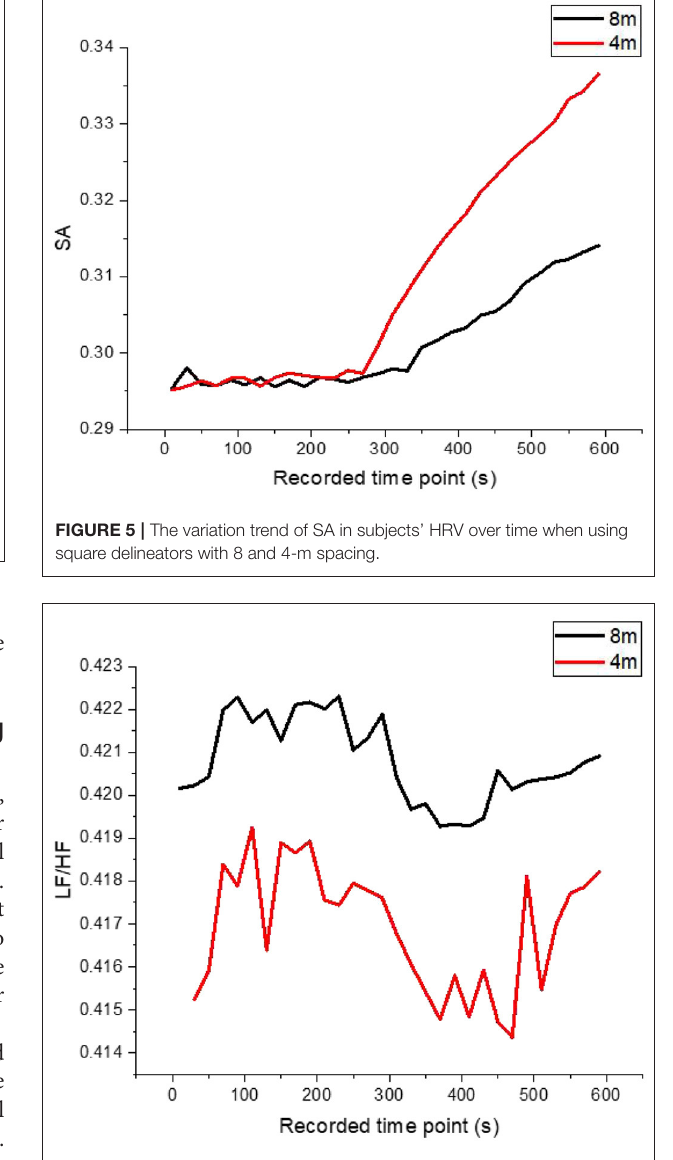
FIGURE 6 | The variation trend of LF/HF ratio in subjects’ HRV over time when using square delineator with 8 and 4-m spacing.